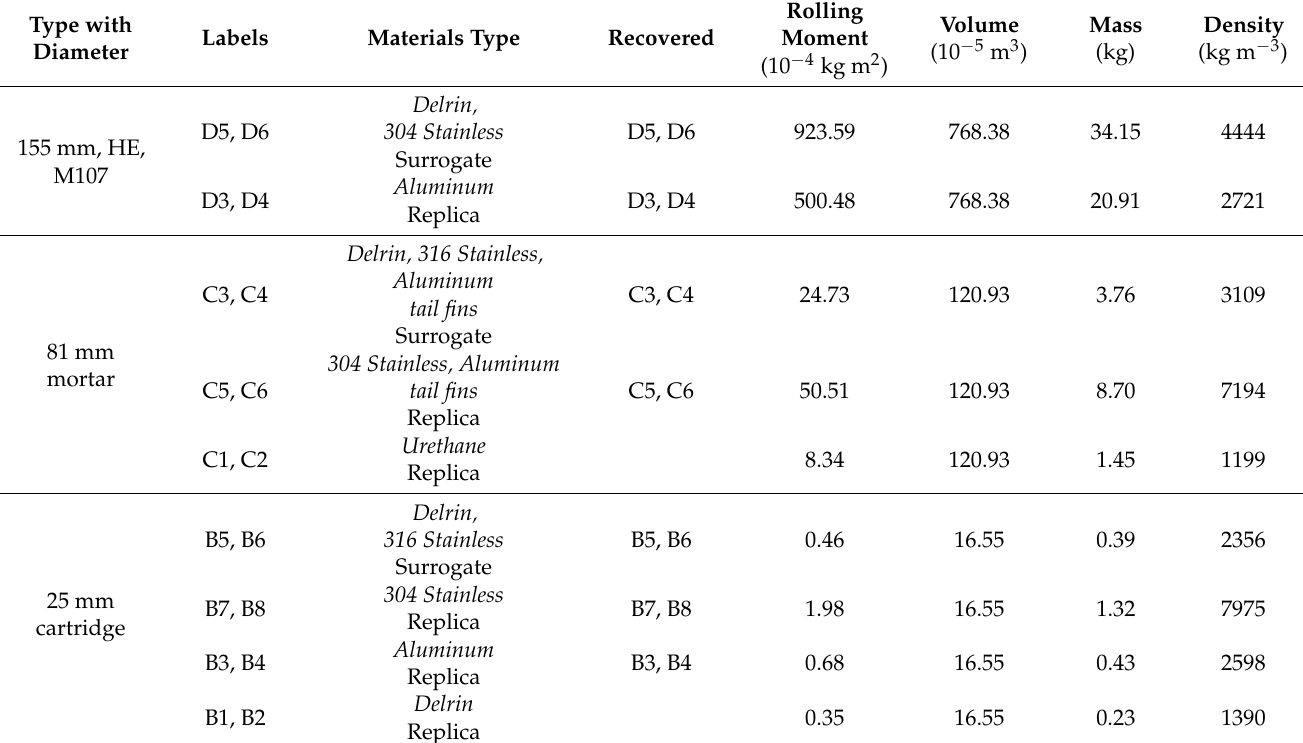
Figure 4. Fabricated surrogates, purchased replicas, and fabricated replicas of ( left ) 155 mm HE M107, ( middle ) 81 mm mortars, and ( right ) 25 mm and 20 mm cartridges (from [13]). Table 1. List of surrogate and replica munitions used during TREX13. A total of 26 objects were deployed and 18 objects were recovered (from [13]). The surrogate munitions were fabricated to have rolling moments within 10% of the estimated rolling moment of the real